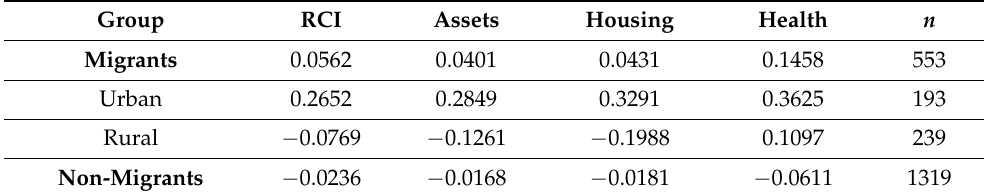
Figure 5. Kernel density estimation of RCI: migrants (urban, rural origin) and non-migrants. Table 1. RCI and average object scores of 1st component of each RM pillar for migrants (rural, urban origin) and